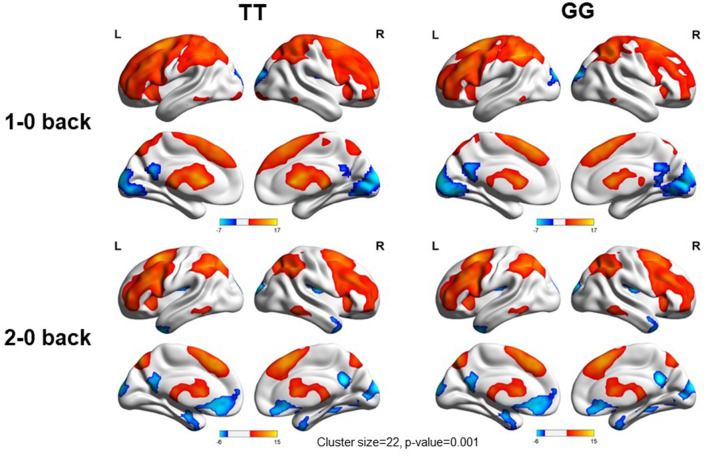
Views of activation during n-back tasks for TT and GT/GG groups displayed on a custom template sagittal brain surface created from subjects in the study. Note. L: Left, R: Right.